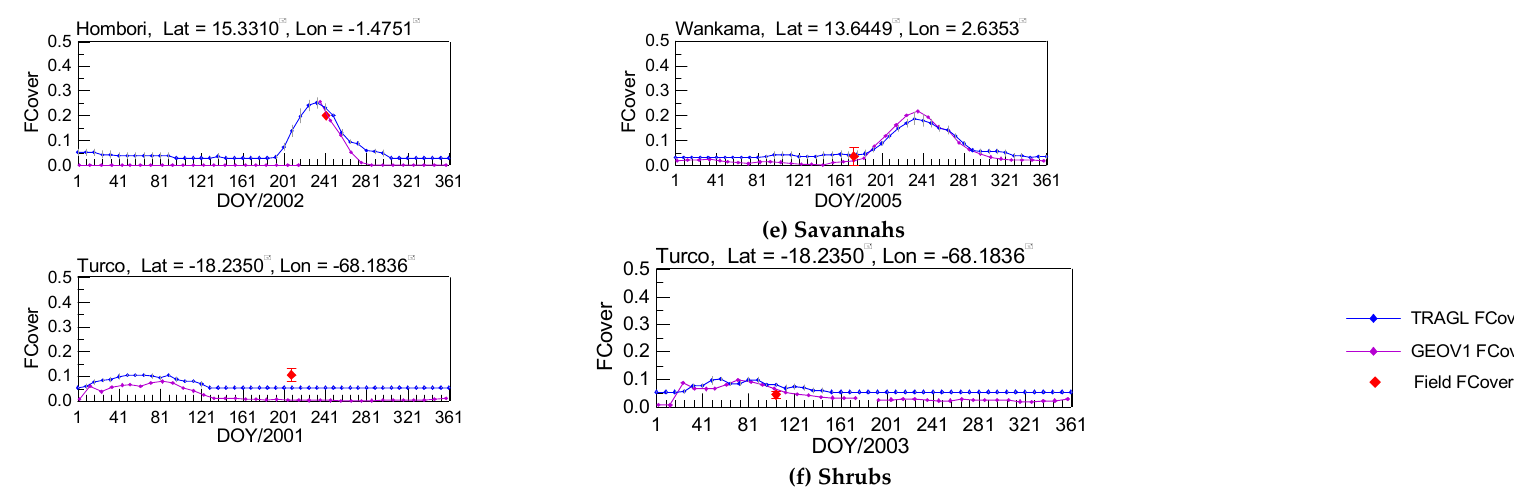
Figure 6. Temporal profiles of the TRAGL and GEOV1 FCover values for several sites with different vegetation types: ( a ) Grassland and Cereal Crops; ( b ) Broadleaf crops; ( c ) Broadleaf forests; ( d ) Needleleaf forests; and ( e ) Savannahs and ( f ) Shrubs.